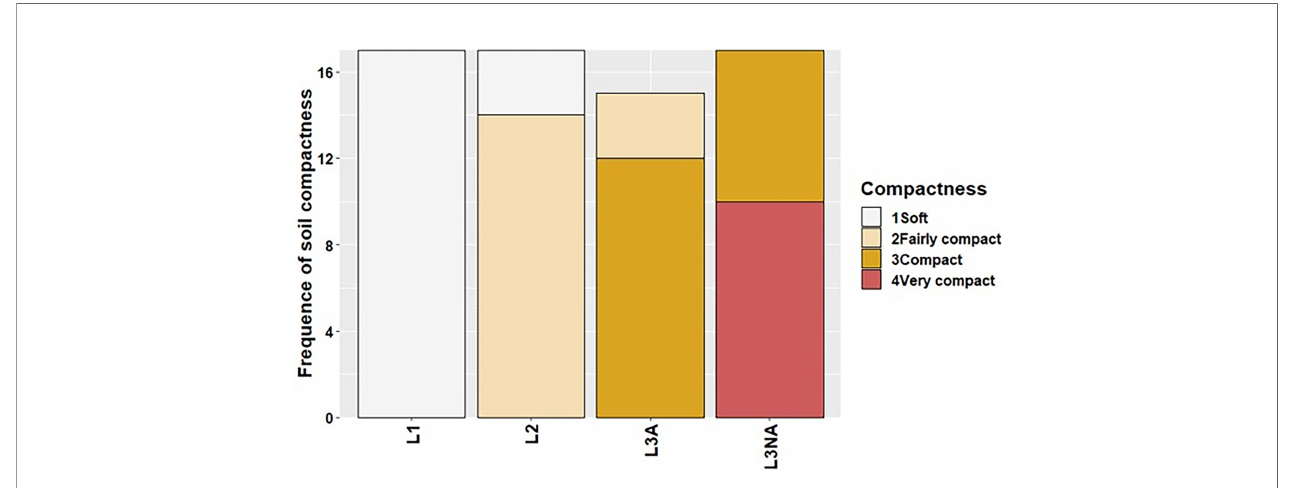
FIGURE 1 | Soil compactness of layers in the pro fi les (L1: layer 1, L2: layer 2, LA: layer 3 amended, LNA: layer 3 unamended).